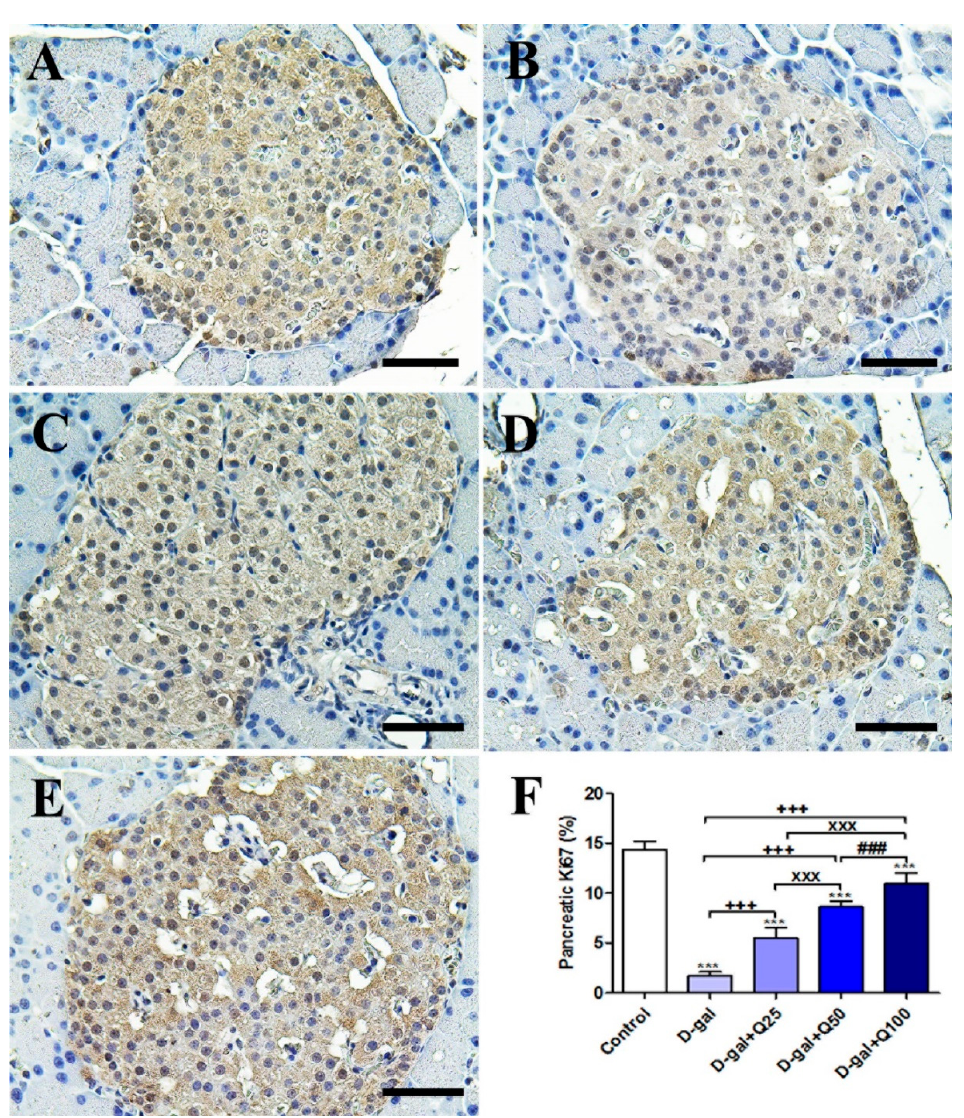
Figure 3. Immunohistochemical staining of rats’ pancreas with Ki67. ( A ) Negative control group. ( B ) D-gal group. ( C ) D-gal+Q25 group. ( D ) D-gal+Q50 group. ( E ) D-gal+Q100 group. ( F ) Quantification of Ki67 in pancreatic islets of Langerhans in different groups. Scale bar = 50 µm . Data were analyzed with one-way ANOVA followed by Tukey’s multiple comparison test. *** p < 0.001 vs control. +++ p < 0.001 vs D-gal. xxx p < 0.001 vs D-gal+Q25. ### p < 0.001 vs D-gal+Q50. Error bars represent mean ± SD.